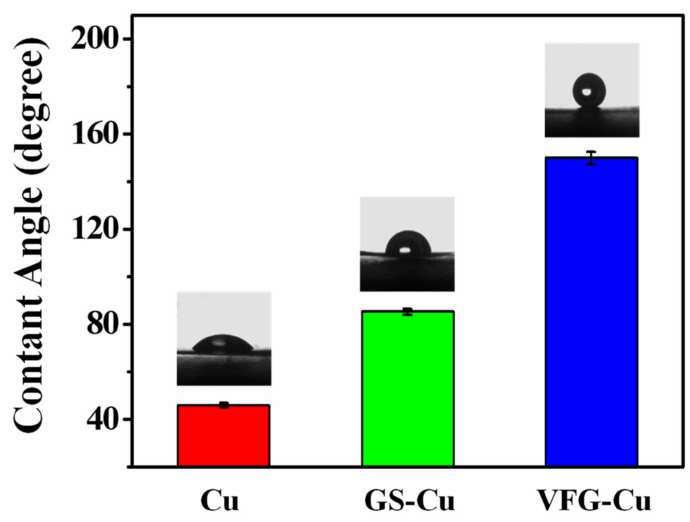
Figure 3. Contact angles of bare Cu, GS-Cu and VFG-Cu.